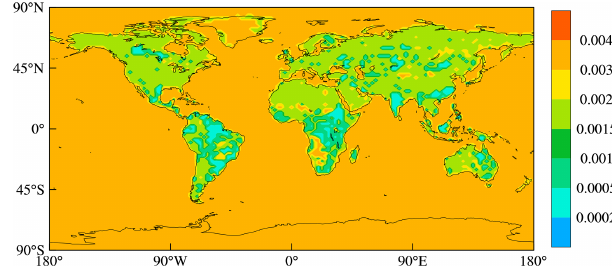
Figure 4. Updated global map of smooth roughness length ( Z 0s ) (cm) estimated from the empirical relationship with soil texture.